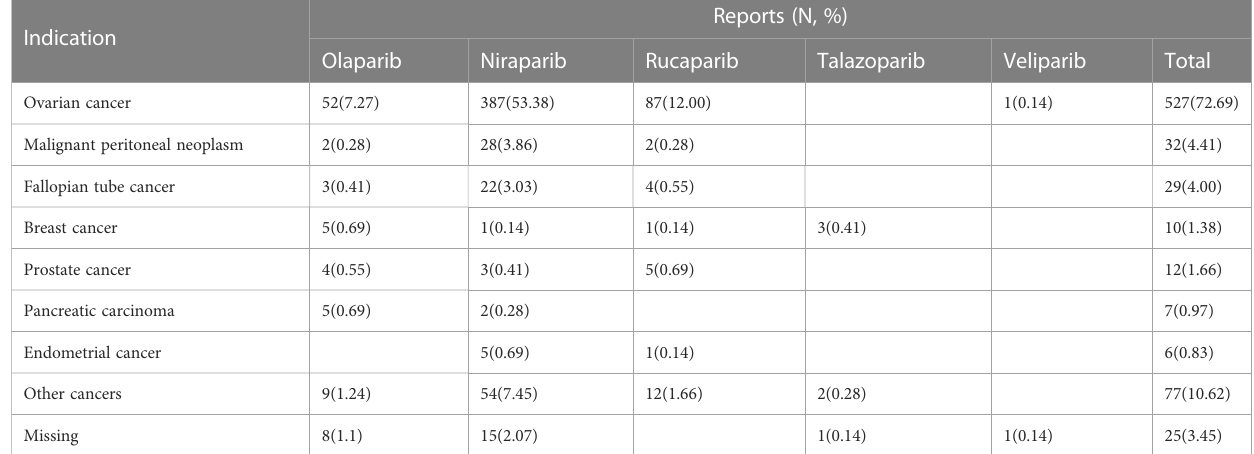
TABLE 3 Indications for the use of the fi ve PARPis.